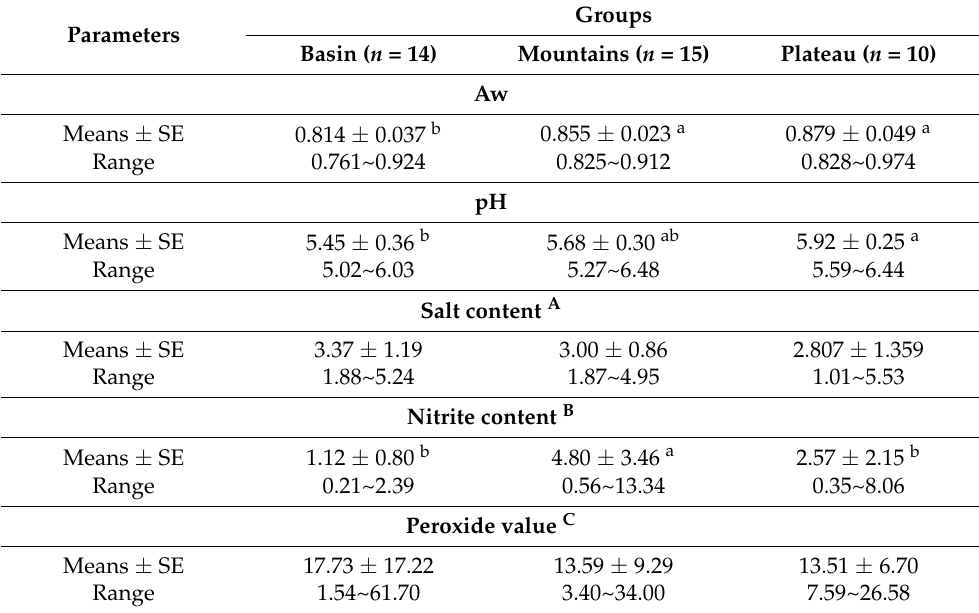
Table 2. Physicochemical indices in Sichuan bacon subjected to three groups of different regions. Parameters